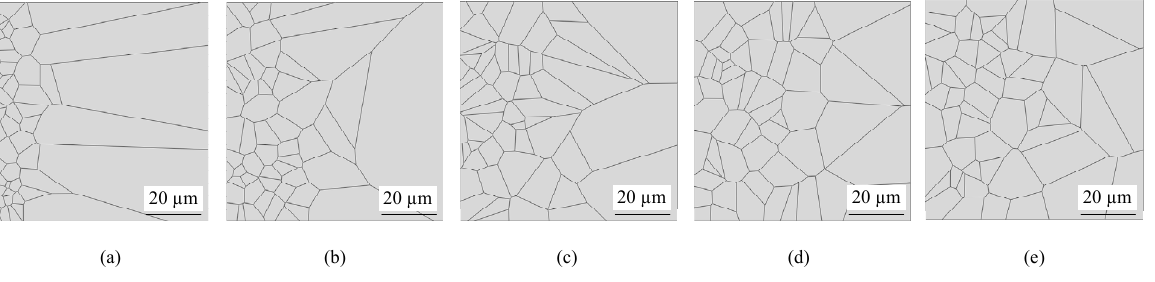
Figure 10. Grain gradient change model: ( a ) grain gradient of 0.5; ( b ) grain gradient of 0.4; ( c ) grain gradient of 0.3; ( d ) grain gradient of 0.2; ( e ) grain gradient of 0.1.